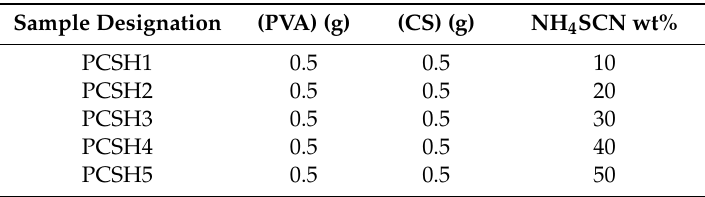
Table 1. Designation and composition of poly(vinyl alcohol) (PVA) / chitosan (CS) / NH 4 SCN blend solid polymer electrolyte (SPE)